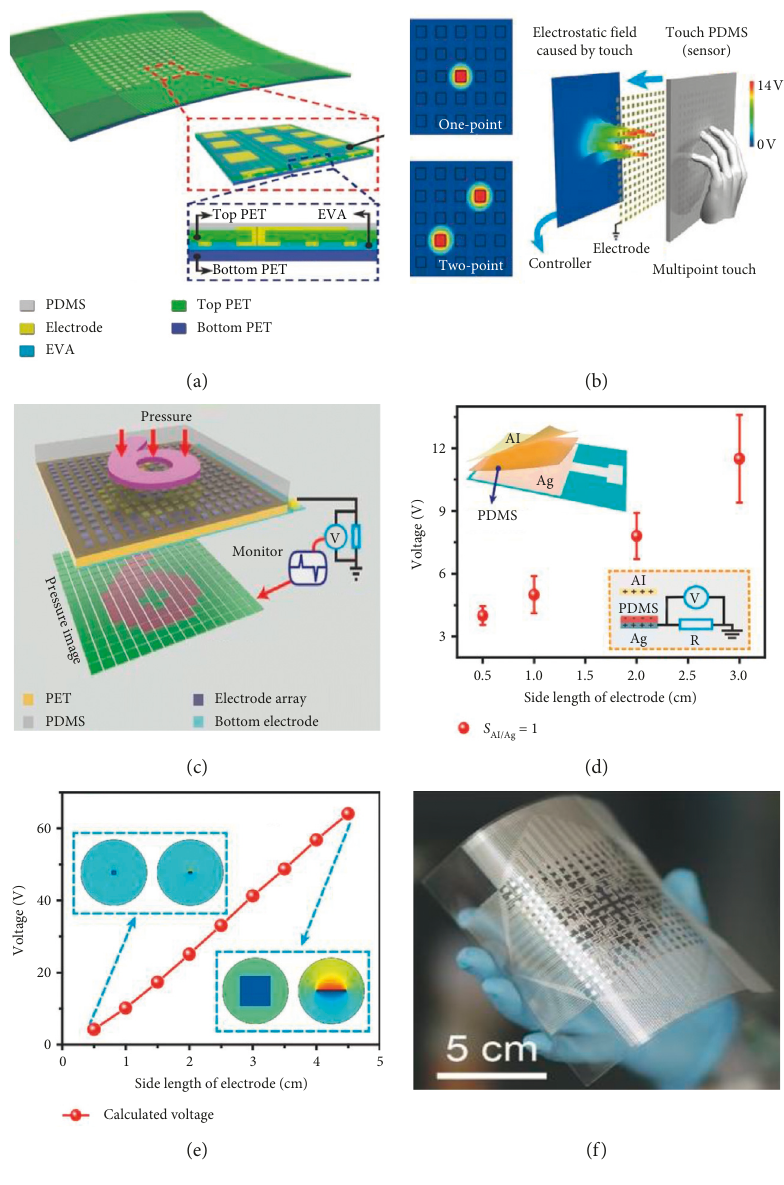
Figure 3: Schematic illustration of TESM. (a) Structure of a 16 × 16 TESM. (b) Schematic of the pressure mapping process. (c) Dem- onstration of the mapping output voltage of the sensor matrix under the pressure. (d) The output voltage increases with increasing contact area at a pressure of ≈ 200kPa. (e) The output voltage simulated using the finite element method with different contact areas. (f) Photograph of a fabricated 16 × 16 TESM with good flexibility (reprinted from Ref. [72], copyright (2016), with permission from WILEY-VCH publishing